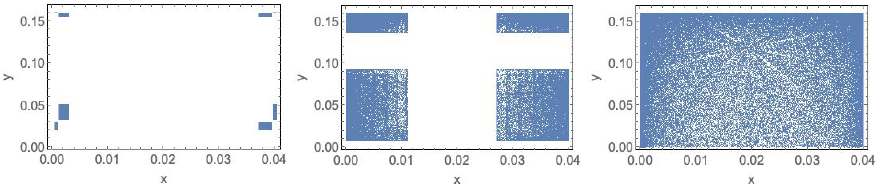
Figure 18. ω -limit sets for Cournot Puu’s model for c 2 = 1 and c 1 = 6.194 ( left ), c 1 = 6.243 ( center ) and c 1 = 6.25 ( right ) taking as initial conditions ( x 0 , y 0 ) = ( 0.01,0.0011 ) . We have computed orbits of length equal to 200,000 and we have drawn the last 100,000 points.